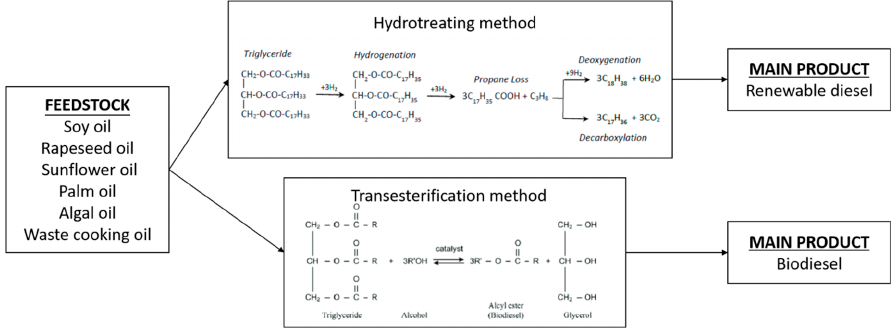
Figure 1. Processing for renewable diesel and biodiesel production.